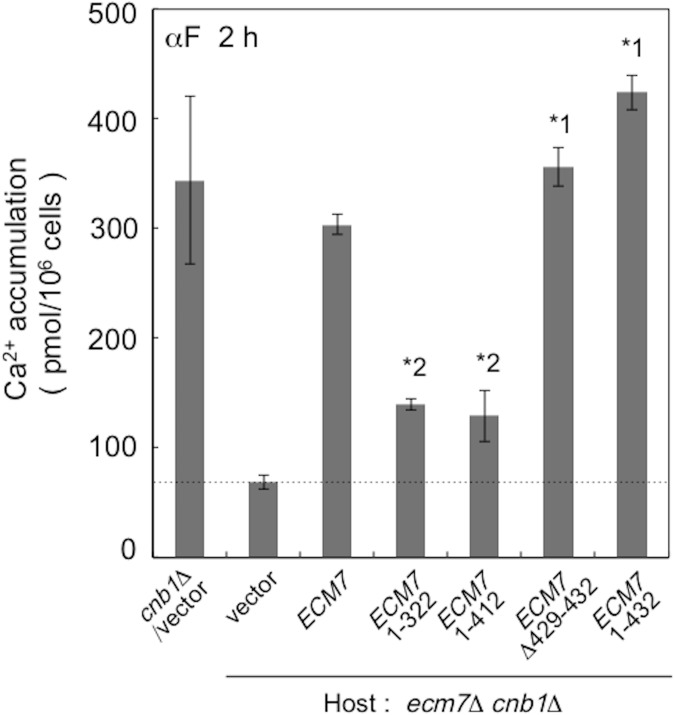
C-terminal truncations after amino acid residues 322 and 412 decrease Ecm7 activity.Experimental conditions and procedures were the same as those described in the legend to Fig 2. The positions of a deletion (Δ429–432) and small truncation (1–432) were also described under the graph. *1, p > 0.05 (cnb1Δ/vector vs. ecm7Δ cnb1Δ/mutated ECM7s); *2, p < 0.05 (cnb1Δ/vector vs. ecm7Δ cnb1Δ/mutated ECM7s). Data are the mean ± SD of three independent experiments.